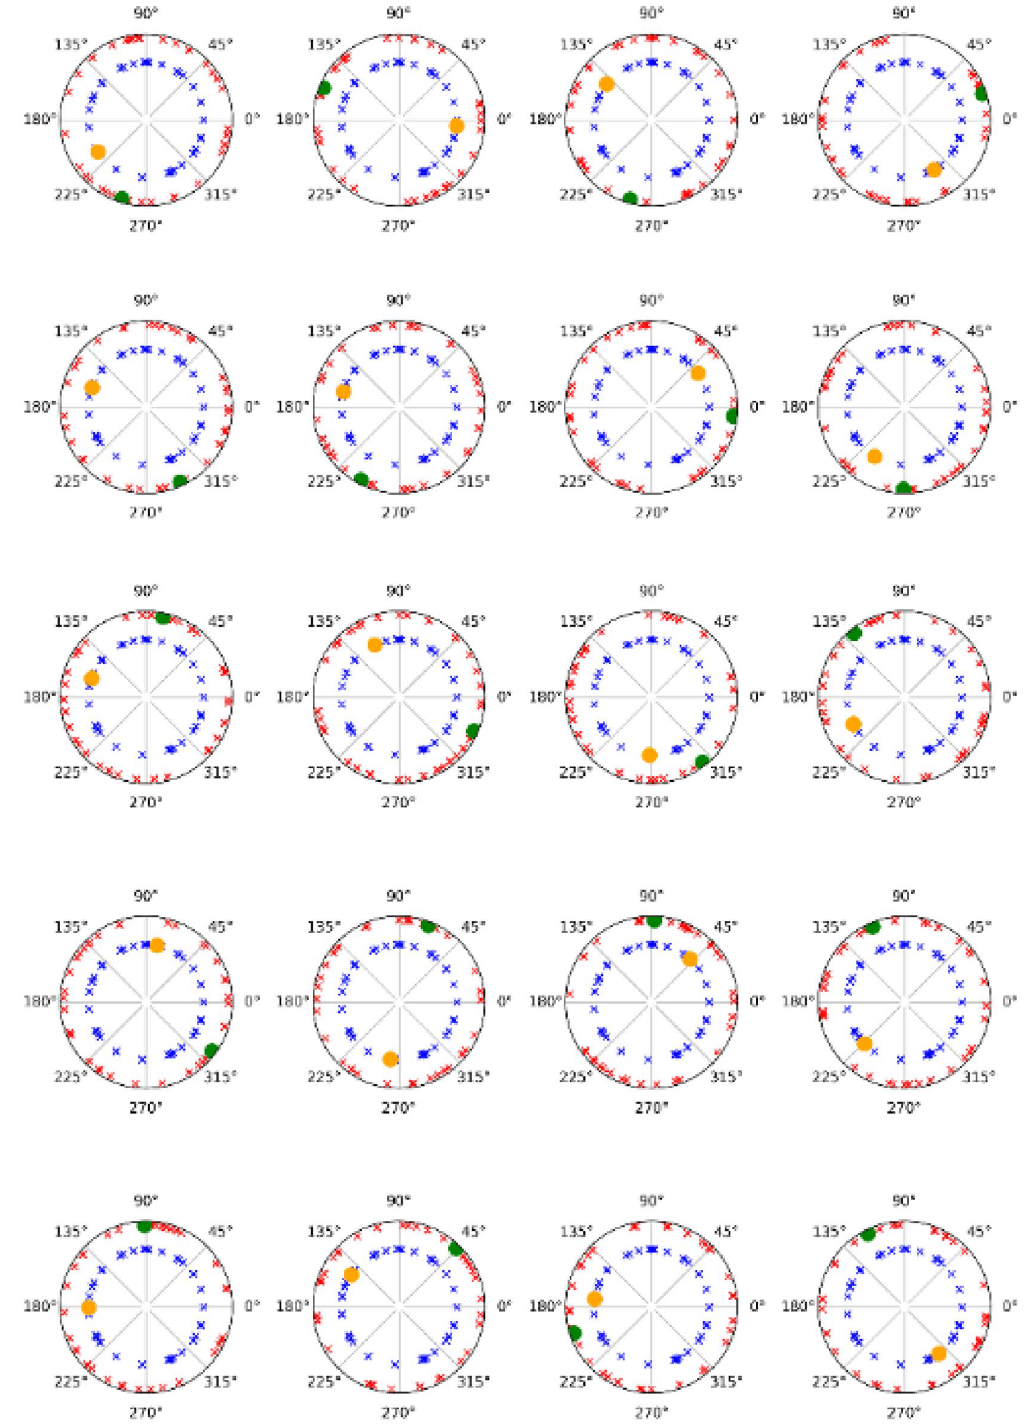
Figure 7. Phase values of the gamma band. The phase-locked values of the gamma band for phase-locked and nonphase-locked activities following the presentation of the target (20 subjects). Green dots and red crosses represent phase-locked and nonphase-locked activity (respectively) when the target is displayed in the left visual field. Yellow dots and blue crosses are when the target is displayed in the right visual field. As indicated in Fig. 4, plotting the individual representations demonstrates the dissociation between both activities (phase-locked and